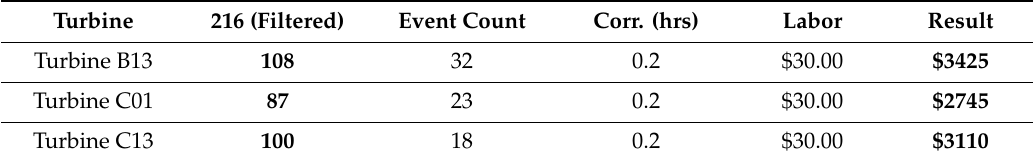
Figure 8. Histograms of 216 events—Turbines (B13), (C01), and (C13). Table 6. Technician costs for the selected wind